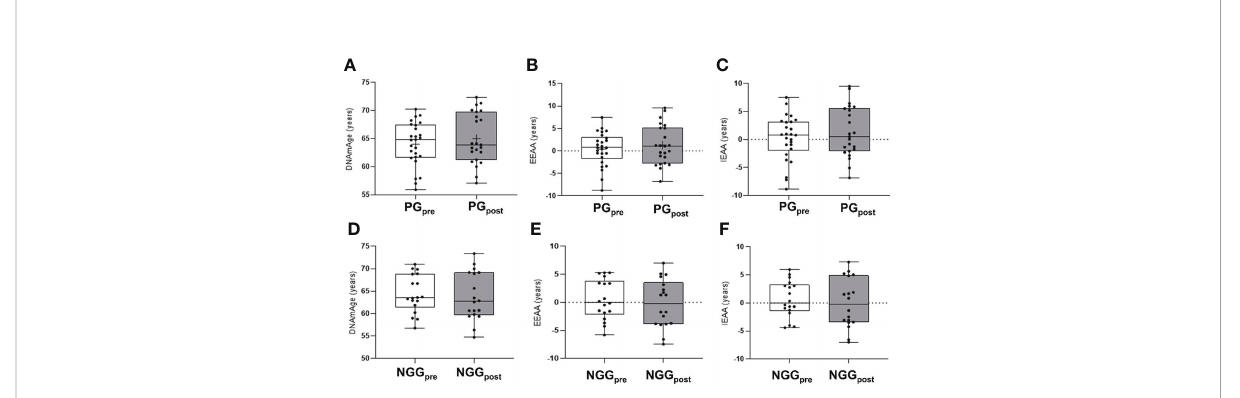
FIGURE 1 Differences in epigenetic age in PRE and POST comparisons 14 weeks of combined training. PG, prediabetes group; NGG, normal glucose group; EEAA, extrinsic epigenetic age acceleration; IEAA, intrinsic epigenetic age acceleration; Pre and pos-intervention comparison for the epigenetic clock in the PG group (panels A – C ). Pre and post-intervention comparison for the epigenetic clock in the NGG group (panels D – F ). (repeated measures two-way ANOVA was used). The presented values were not statically different between groups.